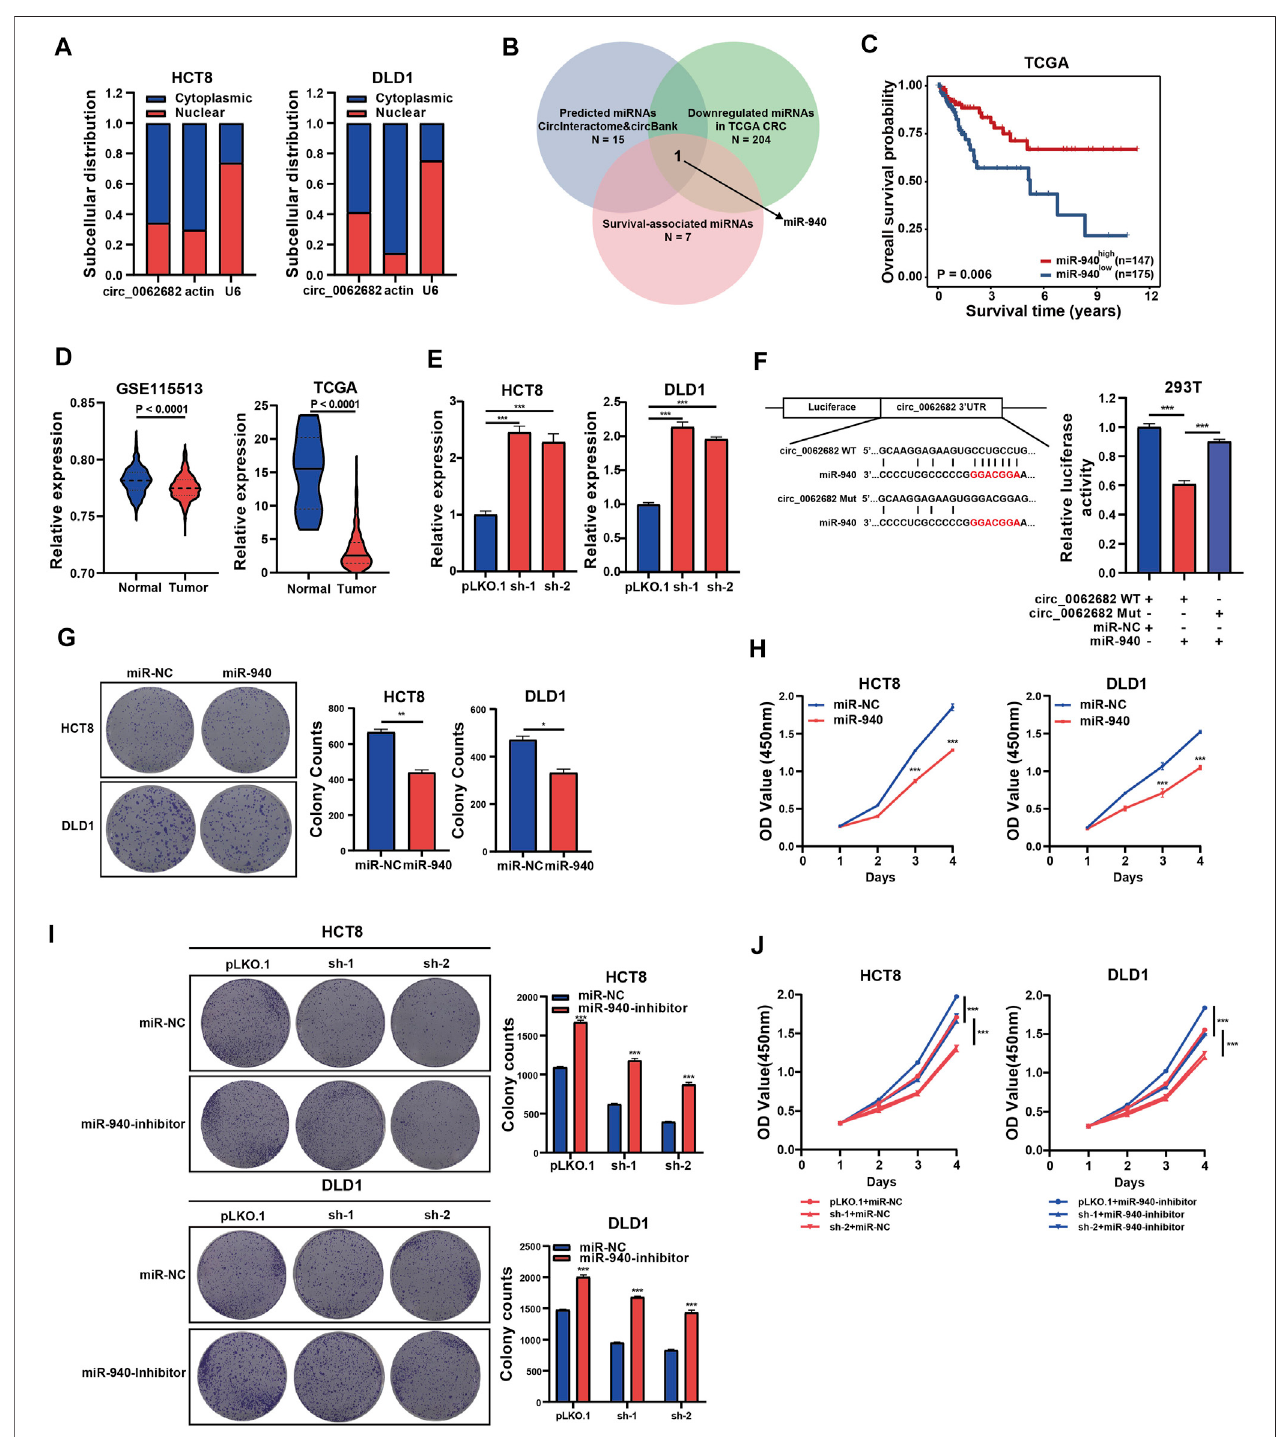
FIGURE 3 | Circ_0062682 functions as a miR-940 sponge. (A) Subcellular localization of circ_0062682 in CRC cells. Nuclear and cytoplasmic fractions were subjected to RNA extraction and qRT-PCR. (B) Venn diagram showing the overlapping of the target miRNAs of circ_0062682 predicted by CircInteractome and CircBank and by the expression and survival analyses of the TCGA CRC cohort. (C) Kaplan-Meier survival analysis of CRC patients with relatively high and low expressionofmiR-940.Thecut-offvalueforgroupingwasdeterminedbyaROCmethod. (D) MiR-940expressionintheGSE115513andTCGACRCdatasets. (E) TheexpressionofmiR-940wasmeasuredincirc_00626820-silencedCRCcellsbyqRT-PCR. (F) Therelativeluciferaseactivitiesofcirc_0062682-WTorcirc_0062682- Mut cotransfected with miR-940 mimic were determined by dual luciferase reporter assays. (G,H) Ectopic miR-940 expression inhibited the colony formation (G) and proliferation (H) ofCRCcells. (I,J) MiR-940inhibitorrescuedthedecreasedactivitiesofcolonyformation (I) andcellproliferation (J) inducedbycirc_0062682knockdown in CRC cells. * p < 0.05; ** p < 0.001; *** p < 0.001.